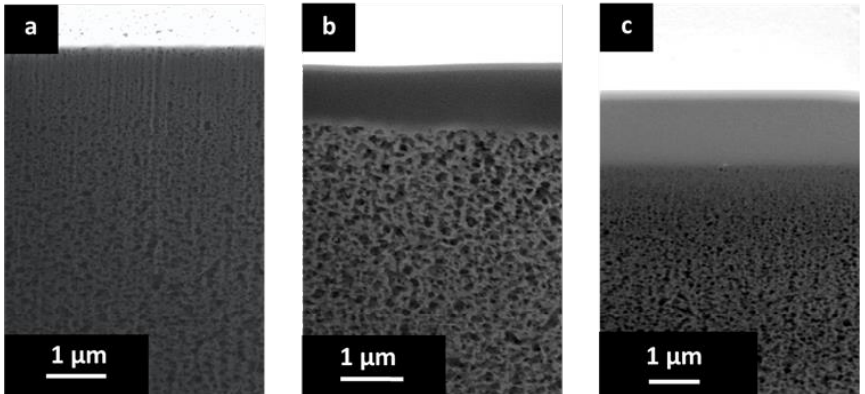
Figure 5. ( a ) SEM cross section of porous PBI structure; ( b ) SEM cross-section of the TFCM with a selective layer of Matrimid ® and Teflon ® AF 2400 protective layer; and ( c ) SEM cross section of the TFCM with a selective layer of 6FDA-6FpDA and Teflon ® AF 2400 protective layer.